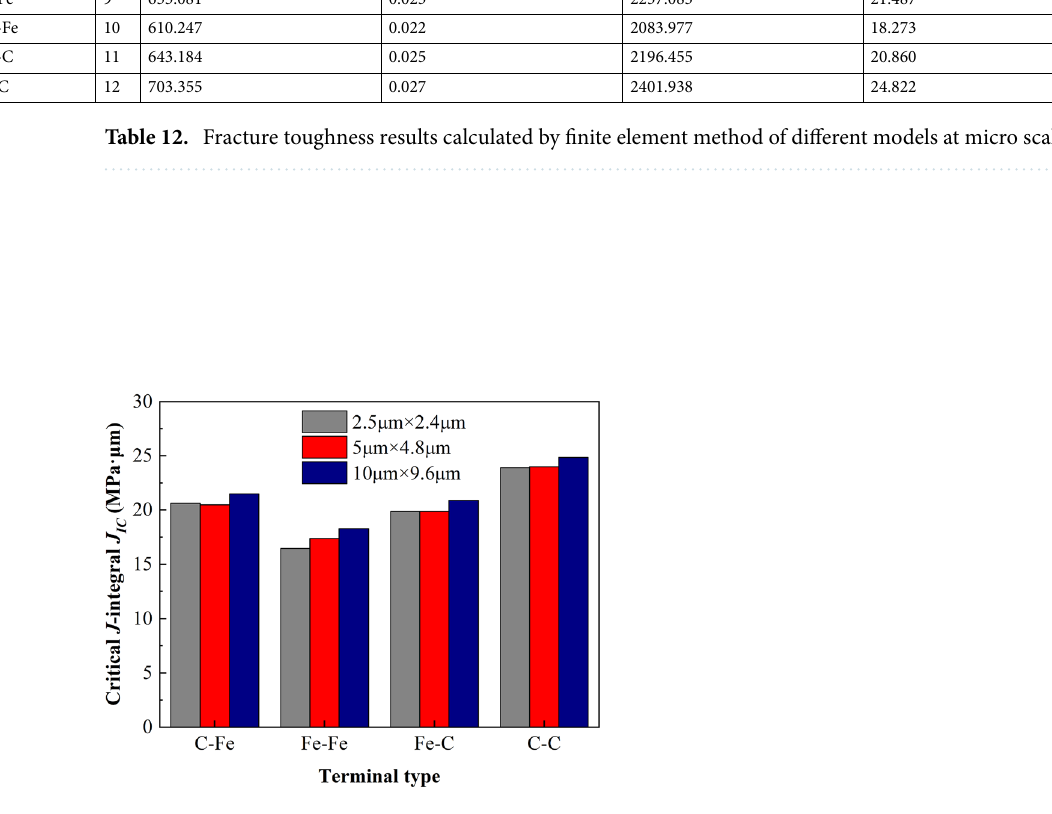
Figure 30. Critical J -integral distribution of each terminal interface under different size